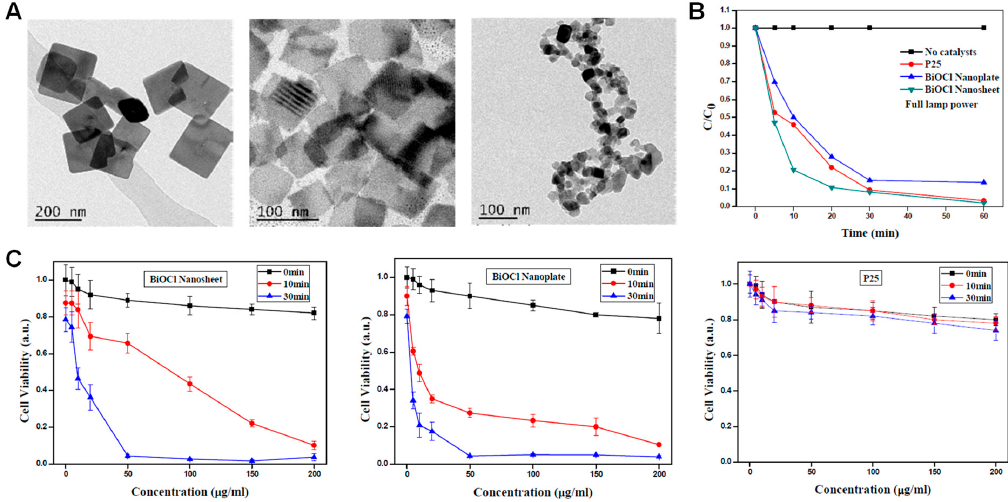
Figure 8. BiOCl NMs used for PDT against cancer cells. ( A ) TEM images of BiOCl nanosheets, nanoplates and P25 nanoparticles; ( B , C ) photocatalytic degradation of methyl violet ( B ) and cell-killing ( C ) abilities of BiOCl nanosheets, nanoplates, and P25 nanoparticles. Reproduced with permission from Ref. [ 108], 2016, Royal Society of Chemistry.